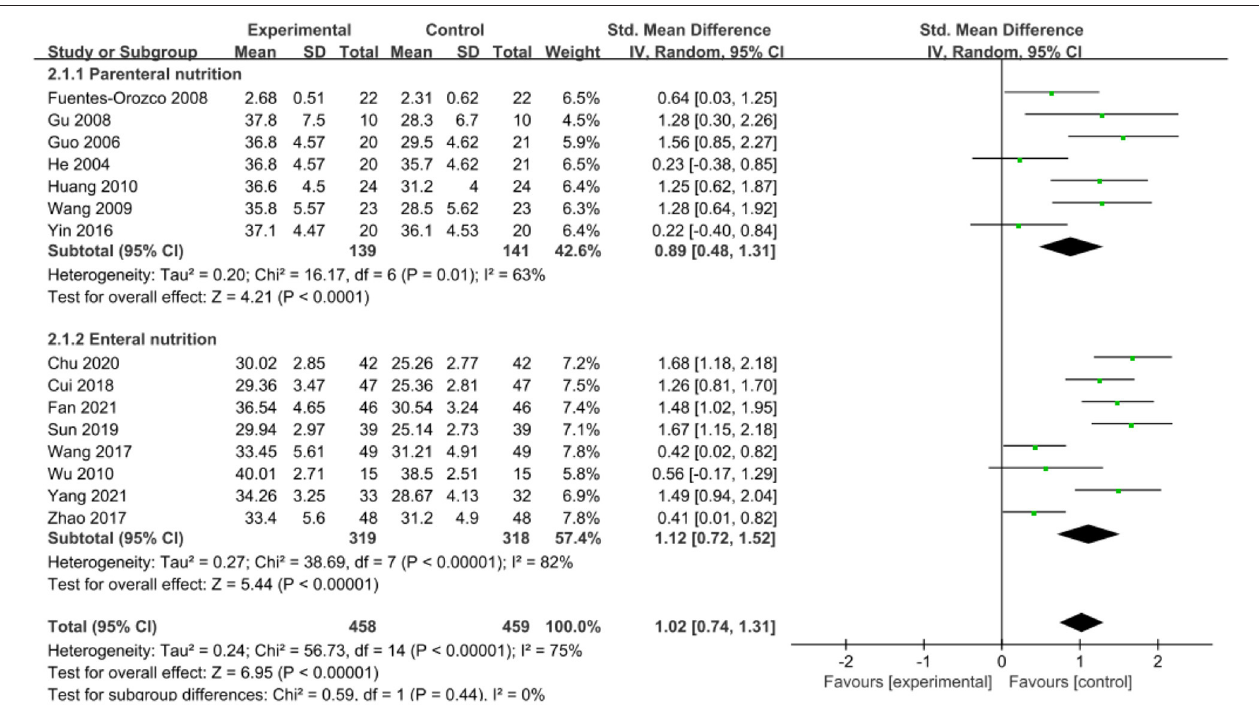
FIGURE 10 | Forest plots of serum albumin associated with experimental group (parenteral or enteral nutrition group supplemented with Gln) vs. control group (conventional nutrition group). I 2 tests and P are the criteria for the heterogeneity test, (cid:7) , pooled standard mean difference; — (cid:4) —, standard mean difference, and the edges of (cid:7) , 95% CI.